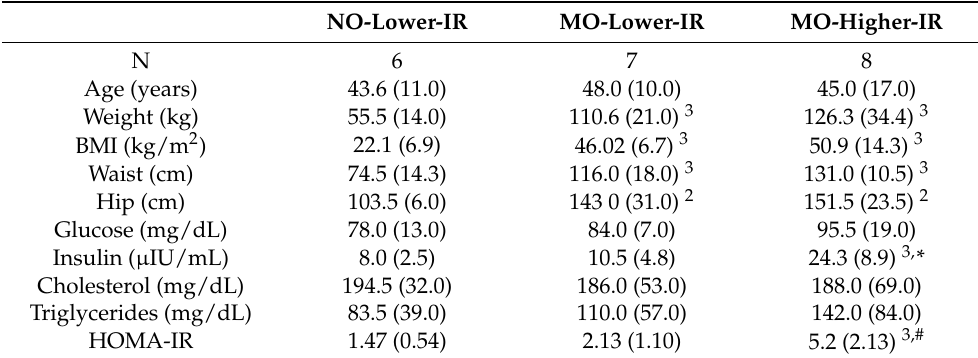
Insulin ( µ IU/mL) Cholesterol (mg/dL) 194.5 (32.0) 186.0 (53.0) 188.0 (69.0) Triglycerides (mg/dL) 83.5 (39.0) 110.0 (57.0) 142.0 (84.0) HOMA-IR 1.47 (0.54) 5.2 (2.13)